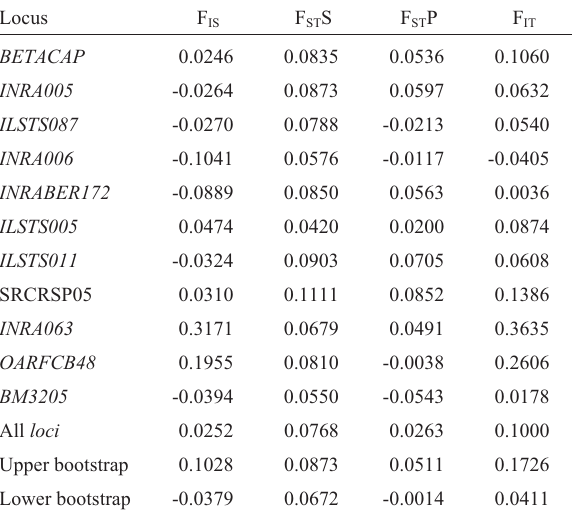
Table 4 - Within population fixation index (F IS ), between population fixation index (F ST P) and between subpopulations fixation index (F ST S) and global consanguinity (F IT ) obtained for each individual locus and all loci combined.